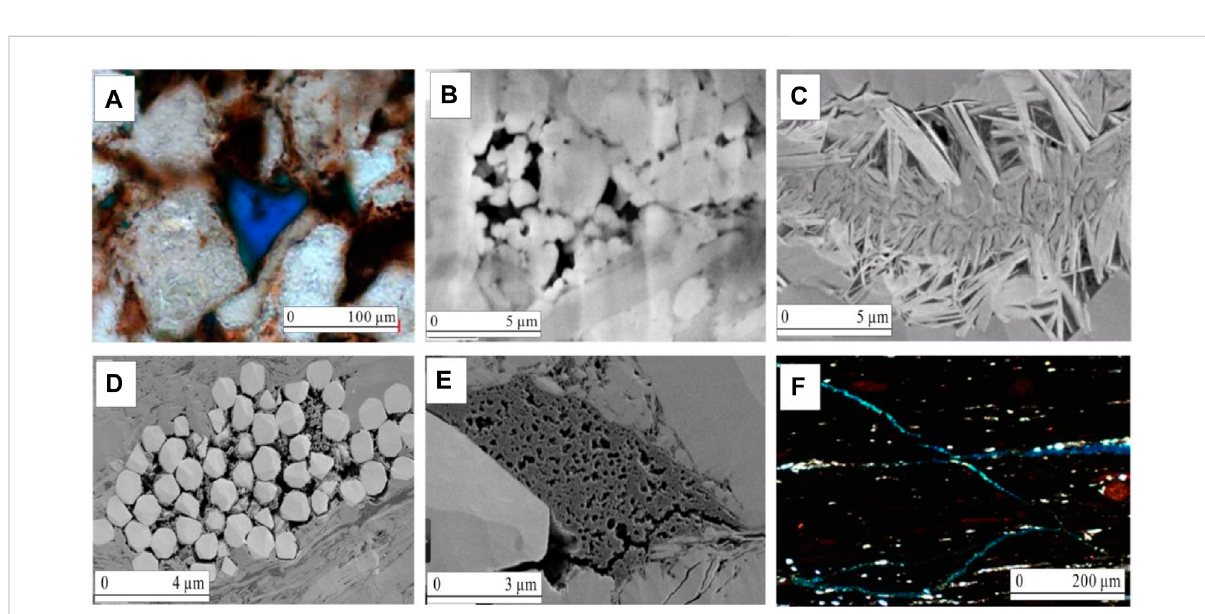
FIGURE 8 Micrographs of pore types in the Chang 7 shale. (A) Residual intergranular pores in siltstone interlayer, Well YY3, single polarized light, 1,325 m; (B) Intergranular dissolution pores, SEM, Well YY8, 1,522.8 m; (C) Intragranular pores of clay mineral aggregates, SEM, Well YY7, 1,140.1 m; (D) Intragranularporesofpyriteaggregates, SEM,Well YY22,1,299.73 m; (E) Organicpores fi lledwithorganicmatterintheinorganic intergranularpores between the debris particles, SEM, Well YY6, 1,307.32 m; (F) Laminates and bedding fractures, cross polarized light, Well YY11, 1,378.37